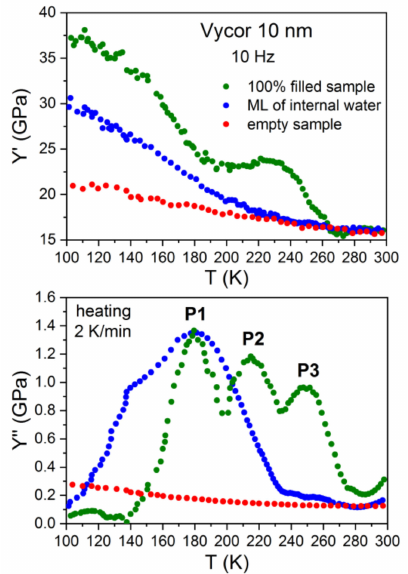
Figure 3. Temperature dependencies of real (Y’, top panel) and imaginary (Y”, lower panel) parts of the complex Young´s modulus of water in Gelsil 10 nm, measured at heating (heating rate 2 K / min) after the sample was slowly (2 K / min) cooled to 80 K. The results of samples fully filled with water (green), partly filled (blue) and empty samples (red) are